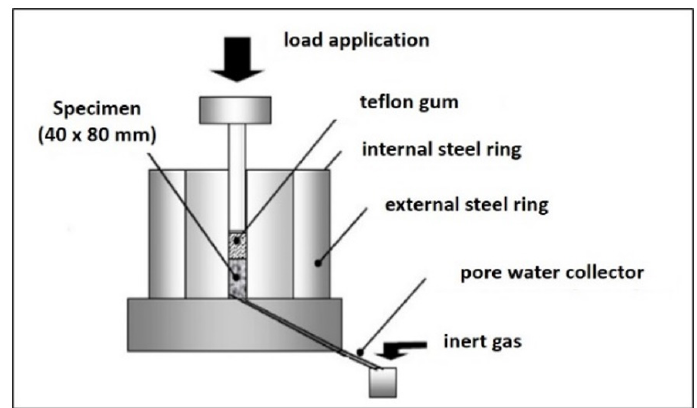
Figure 1. General scheme of the pressure pore water extractor used in this study. Source: Oliveira